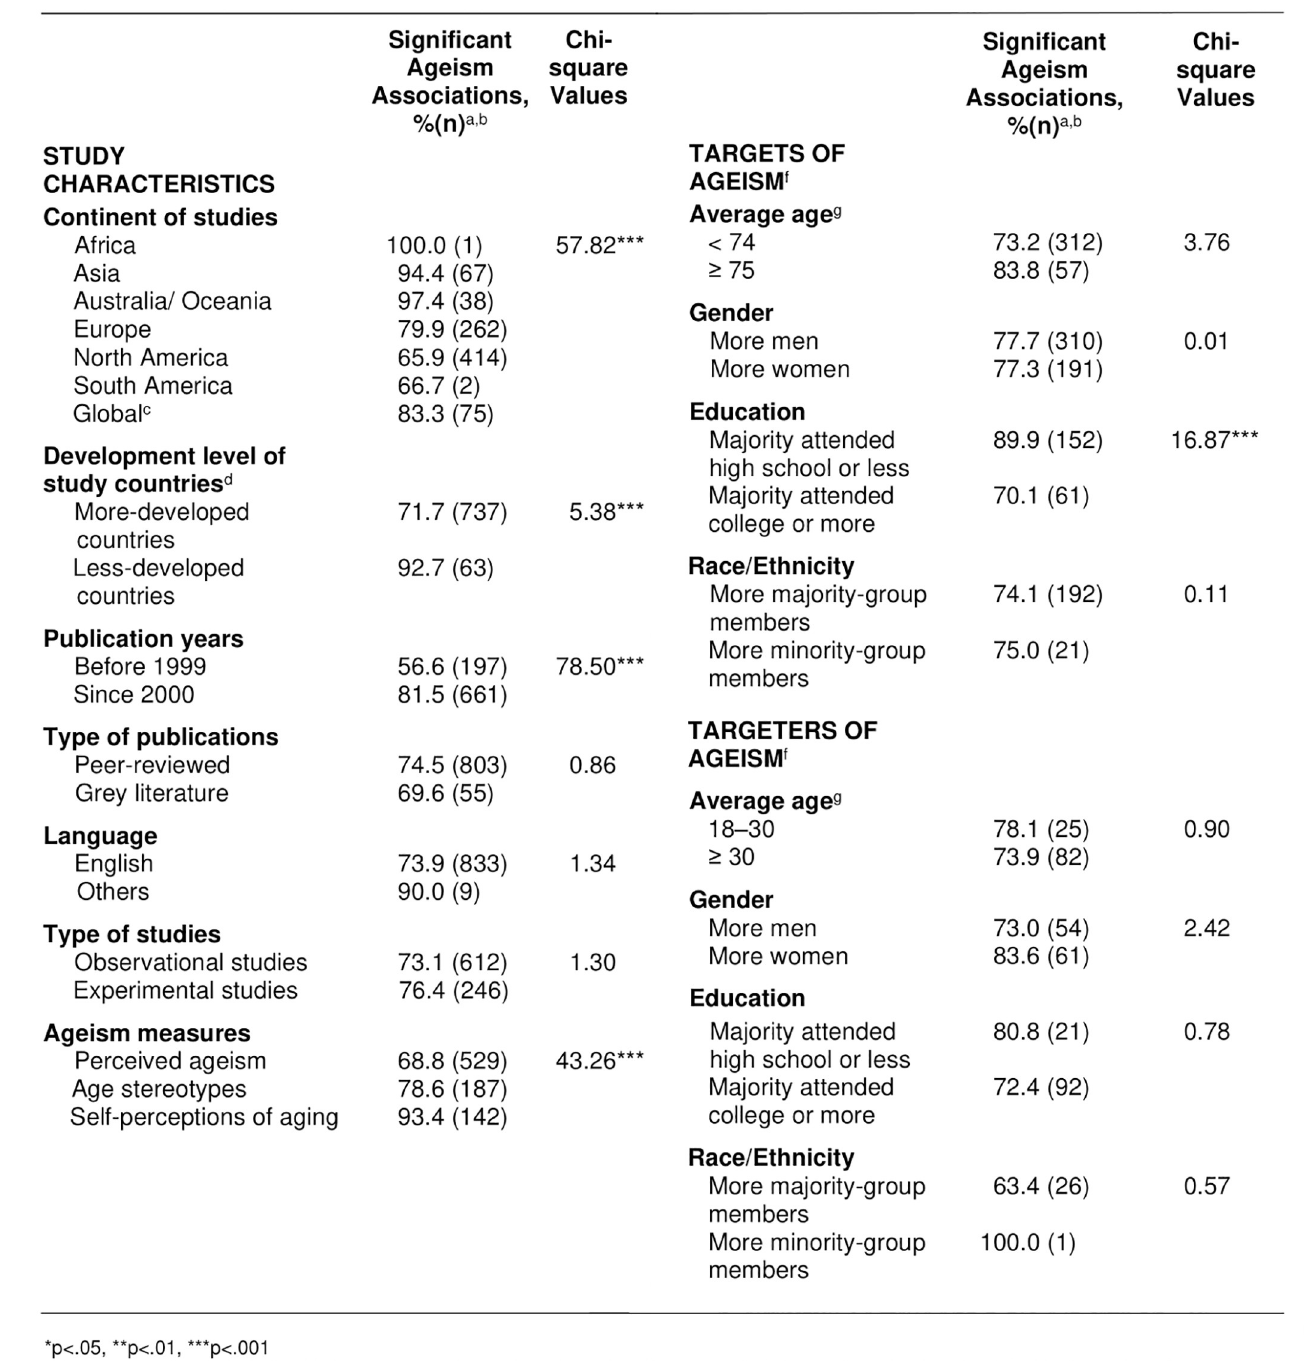
Fig 3. Ageism adversely impacted health across geography, time, and characteristics of studies, targets, and targeters.